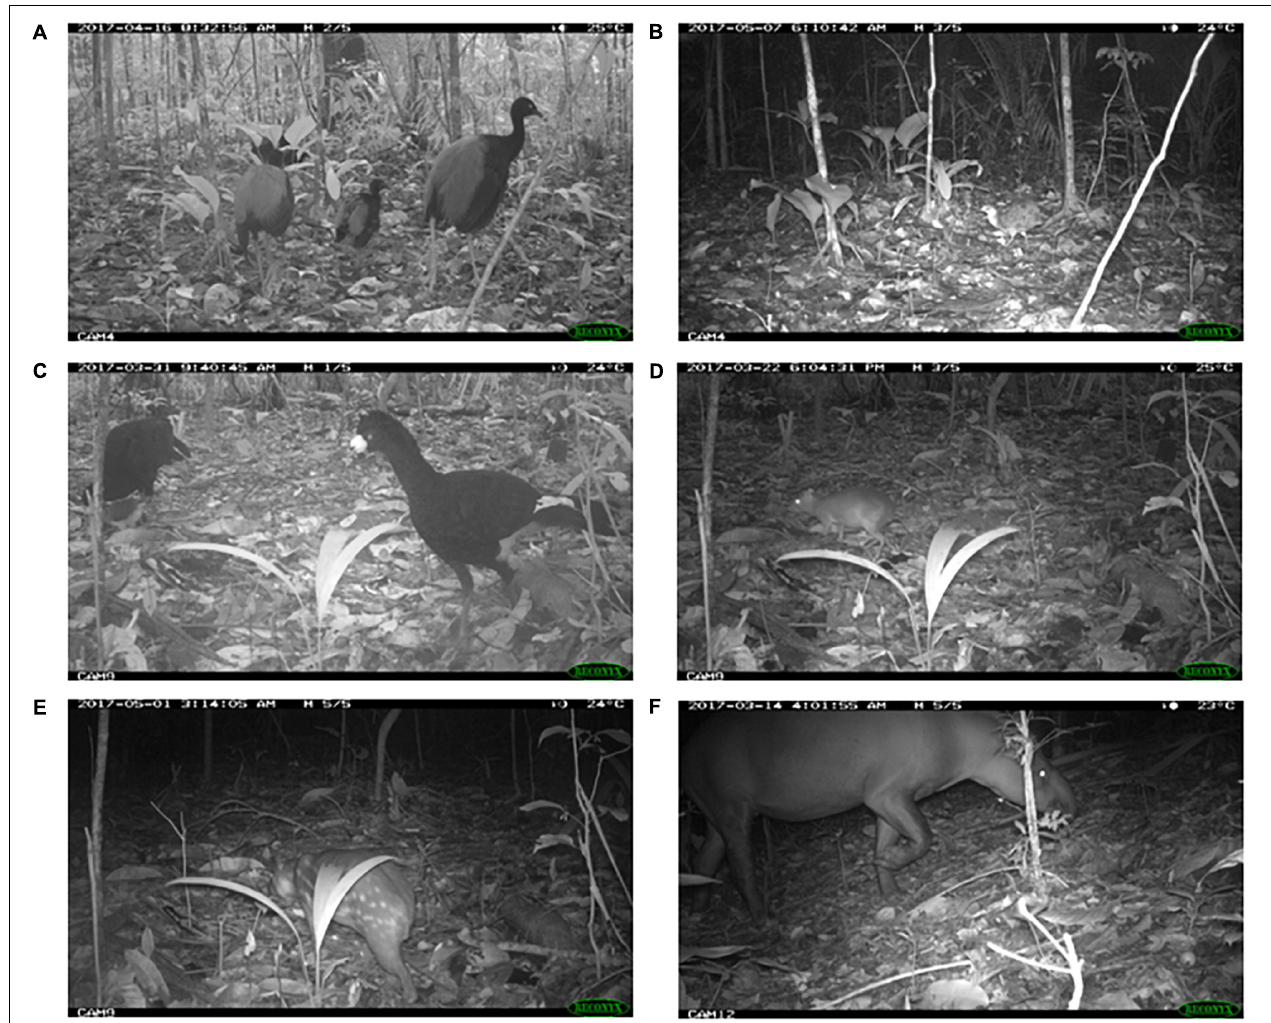
FIGURE 5 | Some camera trap images of the ground-dwelling frugivores observed beneath fruiting Manilkara huberi and M. bidentata trees in forest patches along Road “Nationale 2” (RN2) between Régina and Saint-Georges, French Guiana, in March–May 2017: (A) Gray-winged trumpeter ( Psophia crepitans ); (B)